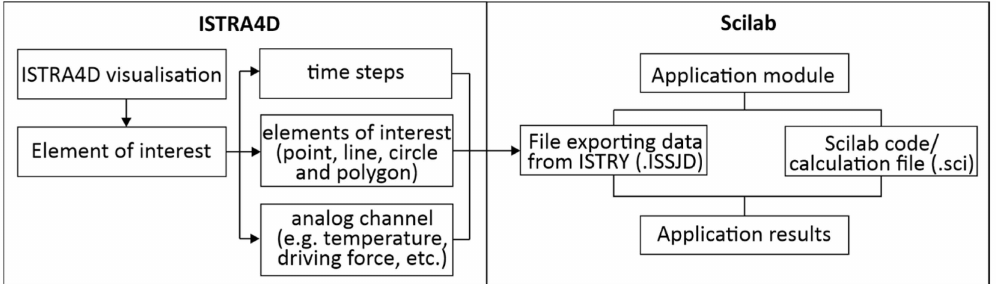
Figure 4. ISTRA4D—Scilab relation.